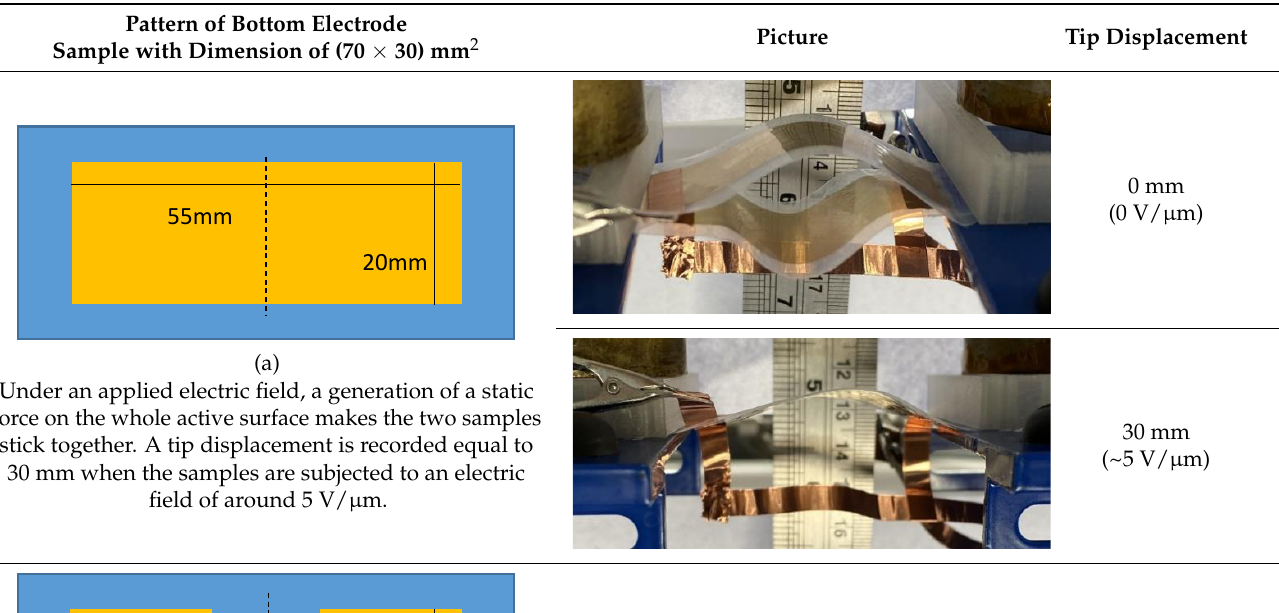
Table 2. Evolution of displacement of the sample considering different patterns of electrodes. Pattern of Bottom Electrode